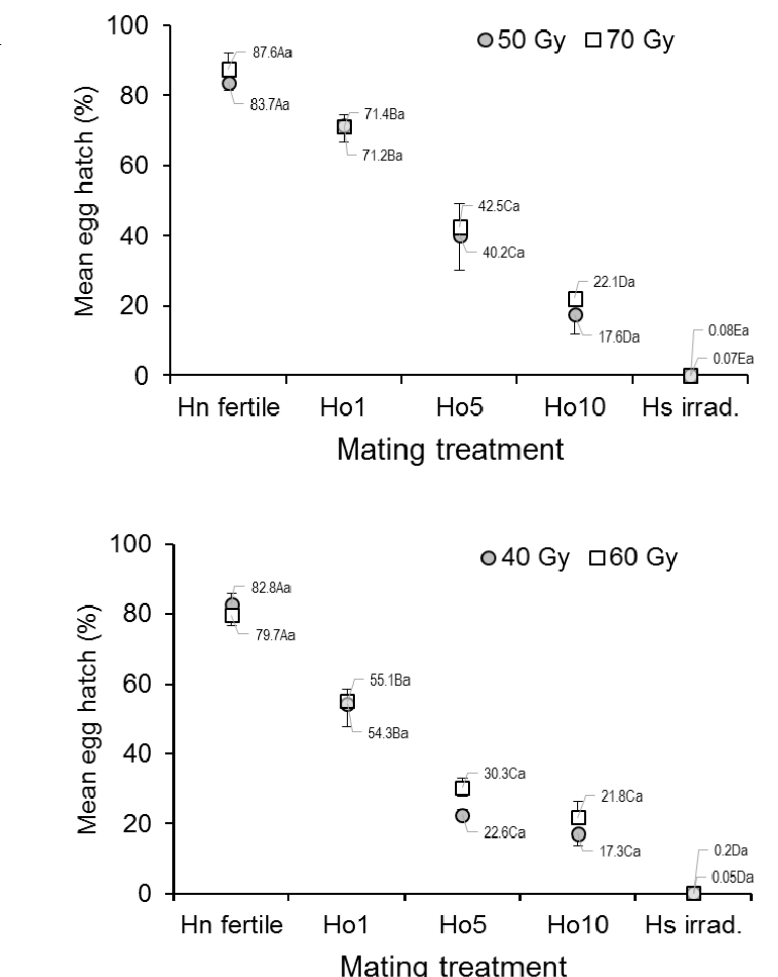
Figure 1. Prevalence (%) of hatching in eggs from ( A ) Aedes aegypti and ( B ) Aedes albopictus females that mated in laboratory cages under different mating treatments. Males were previously exposed to one of two different irradiation doses in the pupal stage. Controls included only fertile males (Hn) and only irradiated males (Hs). Values next to points indicate mean percentages. Means followed by identical letters did not differ significantly for comparisons among mating treatments of the same dose (upper case) and for comparisons of doses within the same mating treatment (lower case) (ANOVA, Tukey p > 0.05). Vertical bars indicate the standard error. For clarity, only half the error bar is shown in some